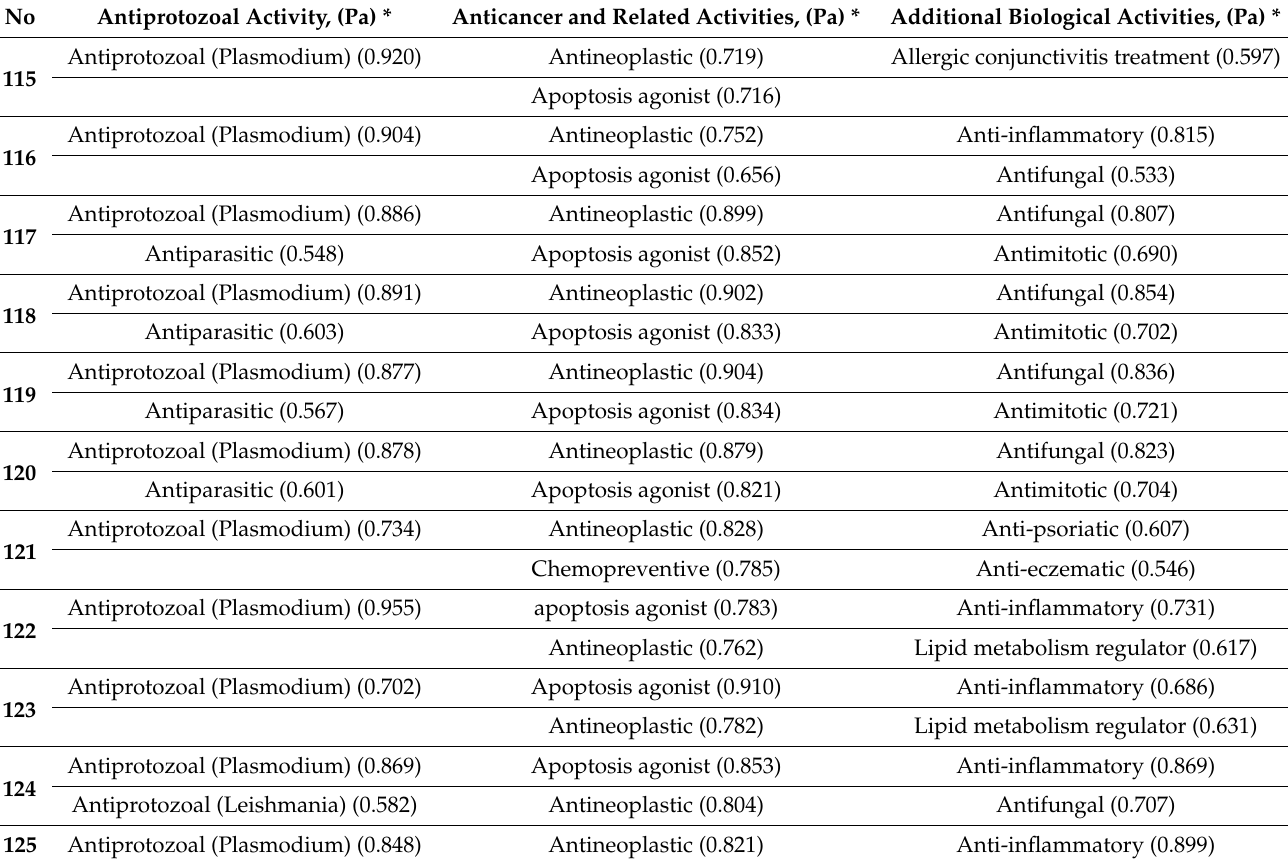
Table 8. Biological activity of natural polycyclic peroxides derived from